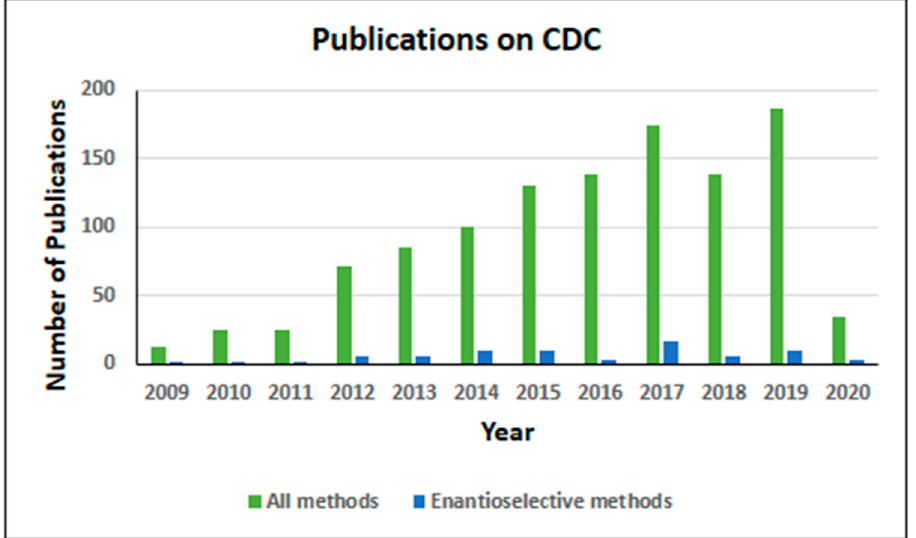
Figure 1. Evolution of the number of publications on enantioselective CDC in the period 2009–2020.